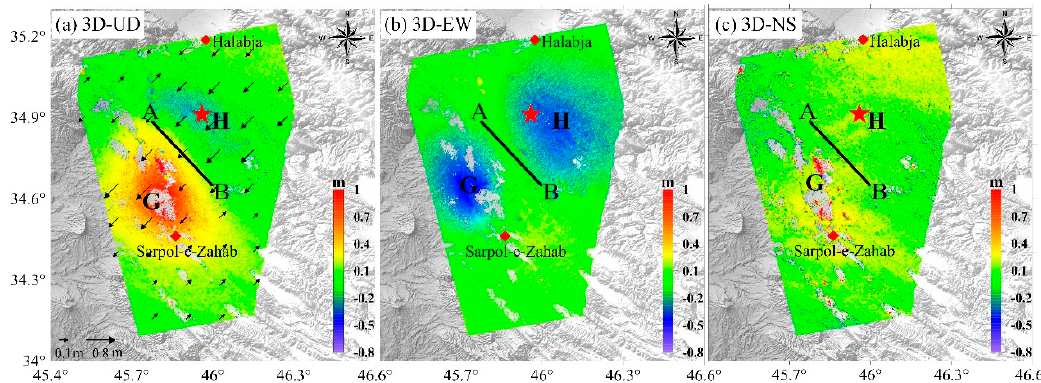
Figure 4. The 3D coseismic displacements maps. ( a ), ( b ), and ( c ) represent the deformation maps in up–down, east–west, and north–south directions. The red star represents the epicenter of the mainshock. The red solid squares represent the city Halabja and Sarpol-e-Zahab. The black line AB is the deformation bound in Figure 2. The arrows in ( a ) are the horizontal motion vectors including EW and N–S displacements vectors.